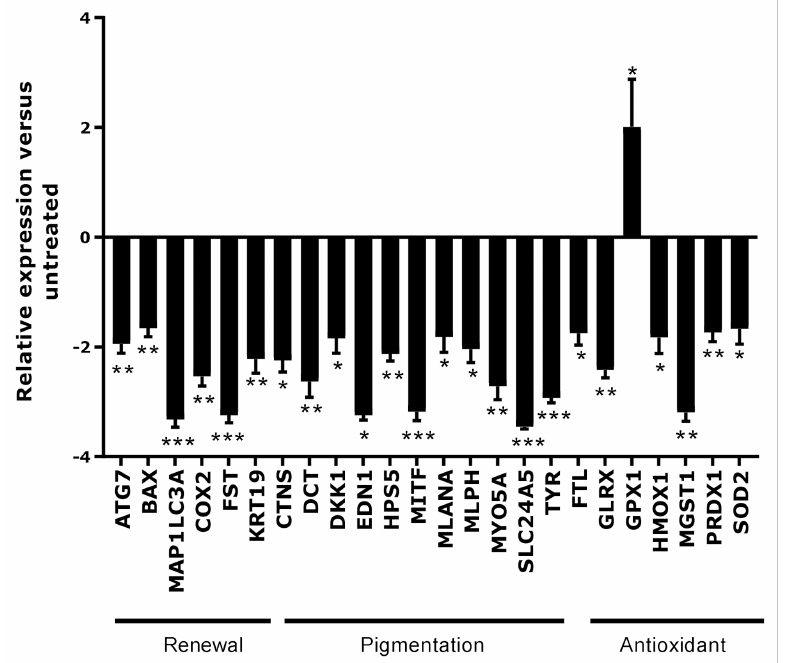
Figure 1. Gene expression analysis in full scalp skin explants after oxidative stress. The results (mean ± SEM) are expressed as relative expression versus the untreated condition. Statistical analysis was performed using one-way ANOVA followed by Fisher’s t -test in comparison with the untreated condition, with * p < 0.05, ** p < 0.01 and *** p <